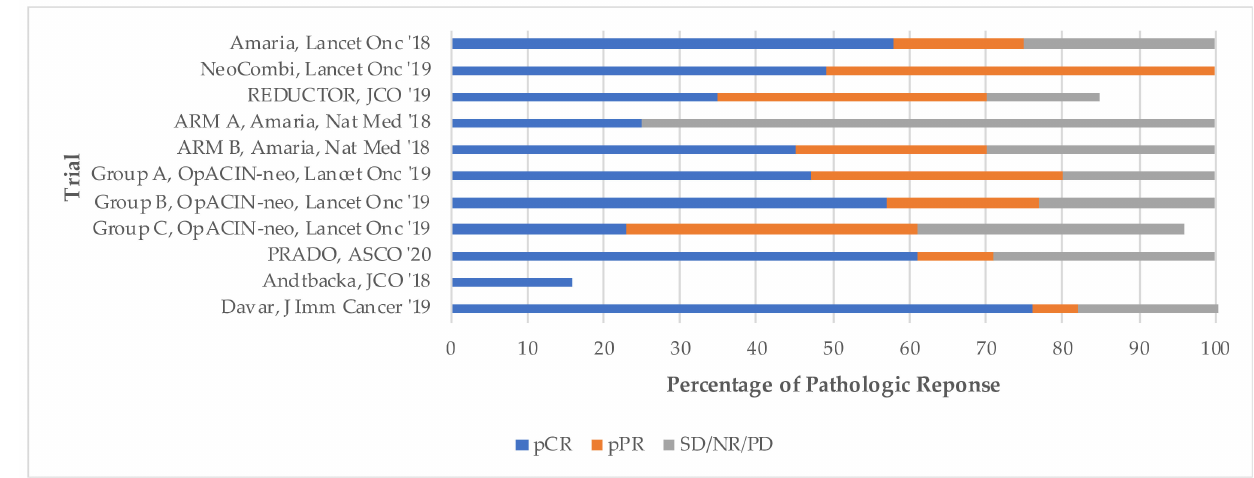
Figure 2. Pathologic response by trial.